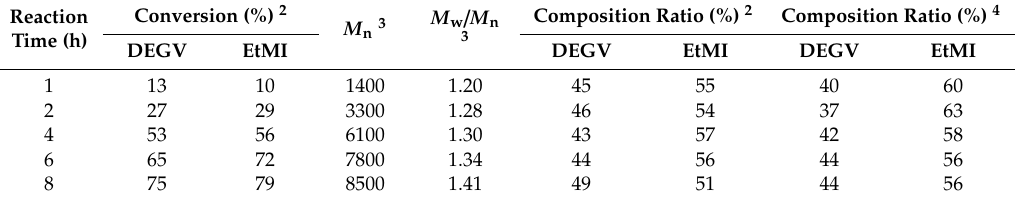
Figure 3. 1 H NMR spectrum of poly(DEGV- alt -EtMI) in CDCl 3 .